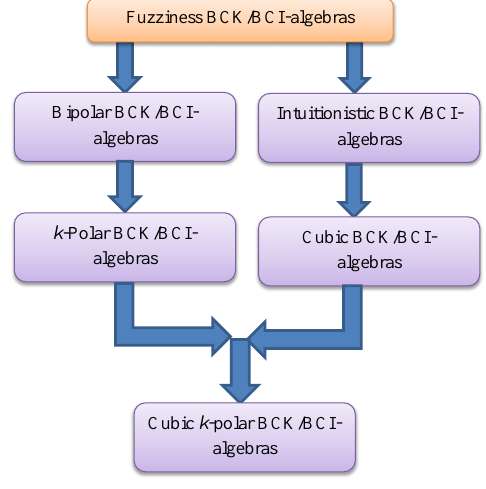
Figure 2. Contributions toward C k P